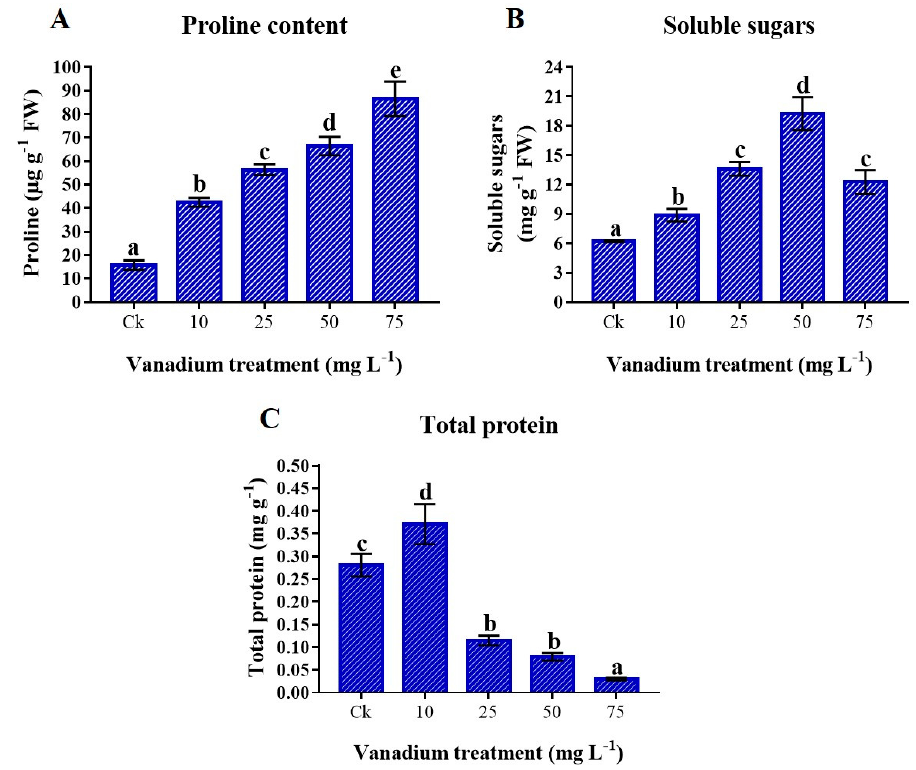
Figure 6. The influence of various V treatments on the osmolytes production in the leaves of sweet potato. ( A ) Proline content, ( B ) soluble sugars, and ( C ) total protein content. Duncan’s test indicates a significant difference ( p < 0.05) between the means of the five treatments indicated by different alphabetical letters.